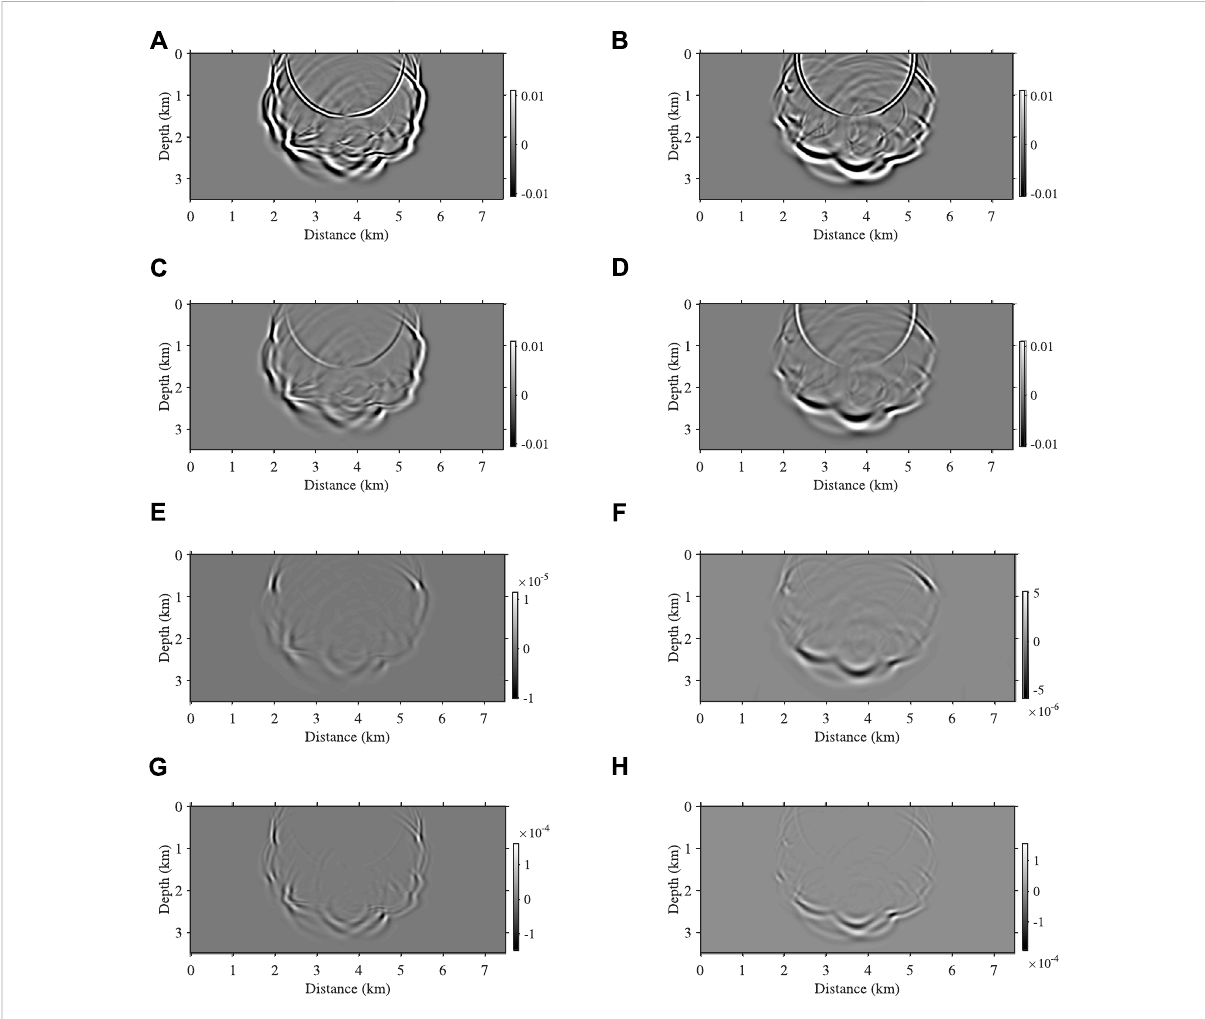
FIGURE 8 Simulated snapshots for v x (A,C) , for v z (B,D) at t = 1.26 s (A,B) show the snapshots in ealstic media, (C,D) are the viscoelastic snapshots computedbythelow-rankschemewiththeranksof m = n =6. (E,F) showthedifferencesbetweentheresultswith m = n =4andthosewith m = n = 6. (G,H) show the differences between m = n = 3 and m = n =